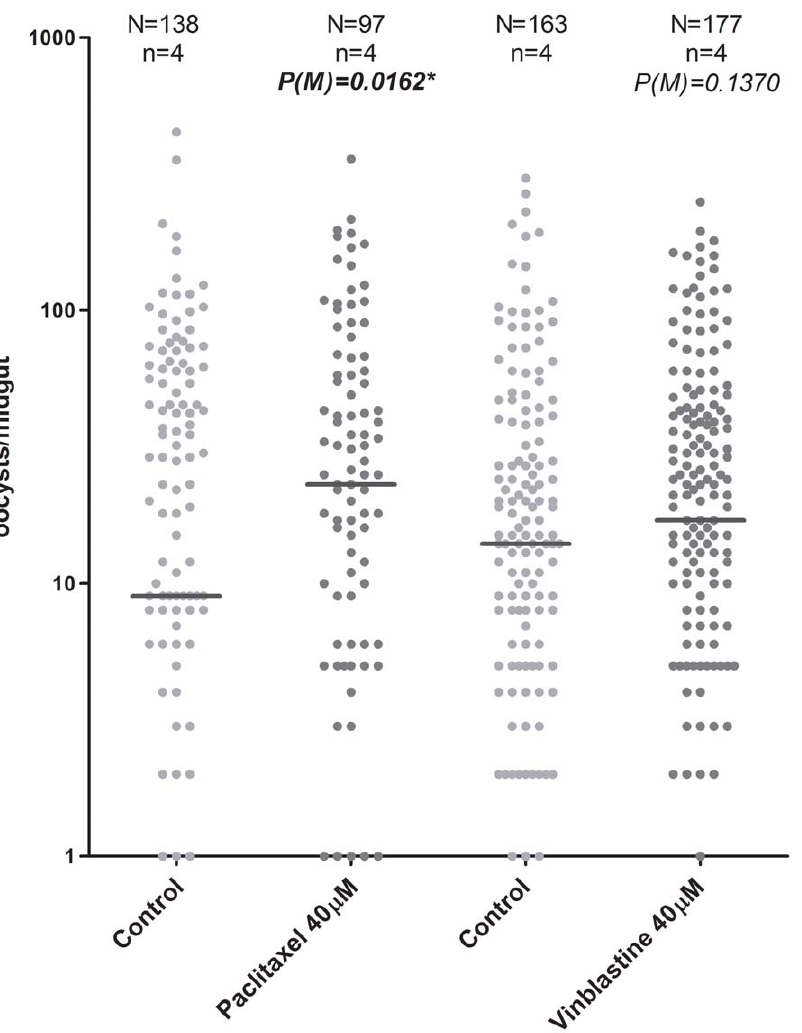
Figure 2. Effect of tubulin inhibitors, paclitaxel and vinblastine, on P.berghei infection at 8 days after an infected blood meal. The dots represent the number of parasites present on individual midguts and the median number of oocysts is represented by a horizontal line. Vinblastine 40 m M, paclitaxel 40 m M. N is the total number of mosquitoes analyzed and n is the number of independent experiments. Oocysts distributions were compared using Mann-Whitney (M) test. *indicates significant differences ( p , 0.05)